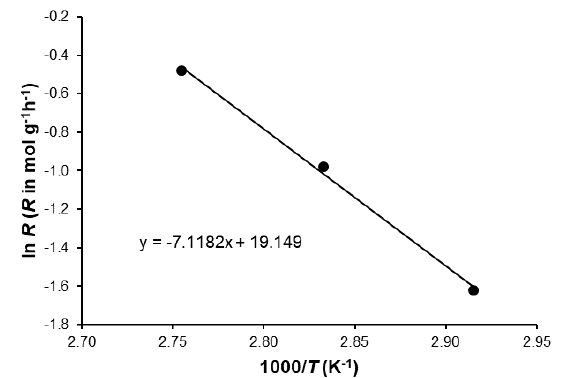
Figure 6. Arrhenius plot for DMF hydroconversion over 9.6%Pt / C + SiO 2 catalyst (0.20 g total weight, 2.5 mg Pt / C) at 6.8 kPa DMF partial pressure, 70-90 ◦ C, 40 mL · min − 1 flow rate ( E = 59.2 kJ · mol − 1 ).